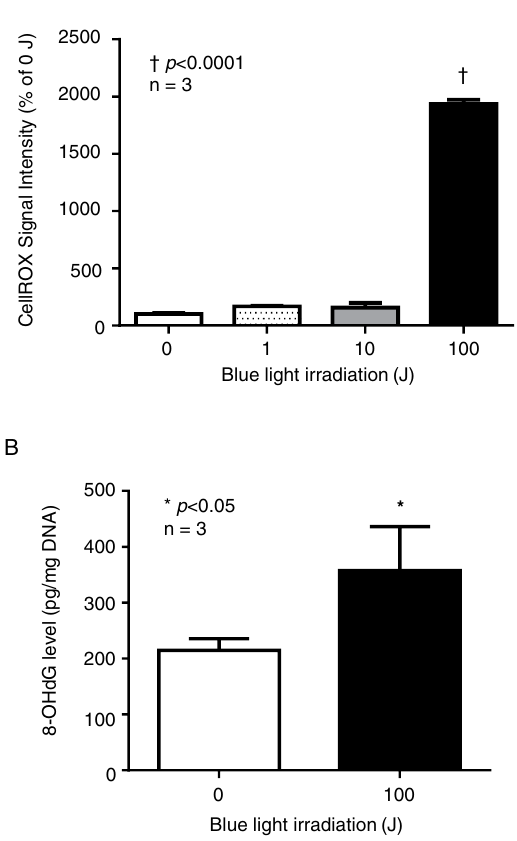
Figure 5. Oxidative stress induced by blue light irradiation of P . gingivalis . ( A ) ROS generation levels upon blue light irradiation in P . gingivalis . (n = 3) † Significant difference ( p < 0.0001). ( B ) Generation of 8-OHdG upon blue light irradiation of P . gingivalis (n = 3) * Significant difference ( p <